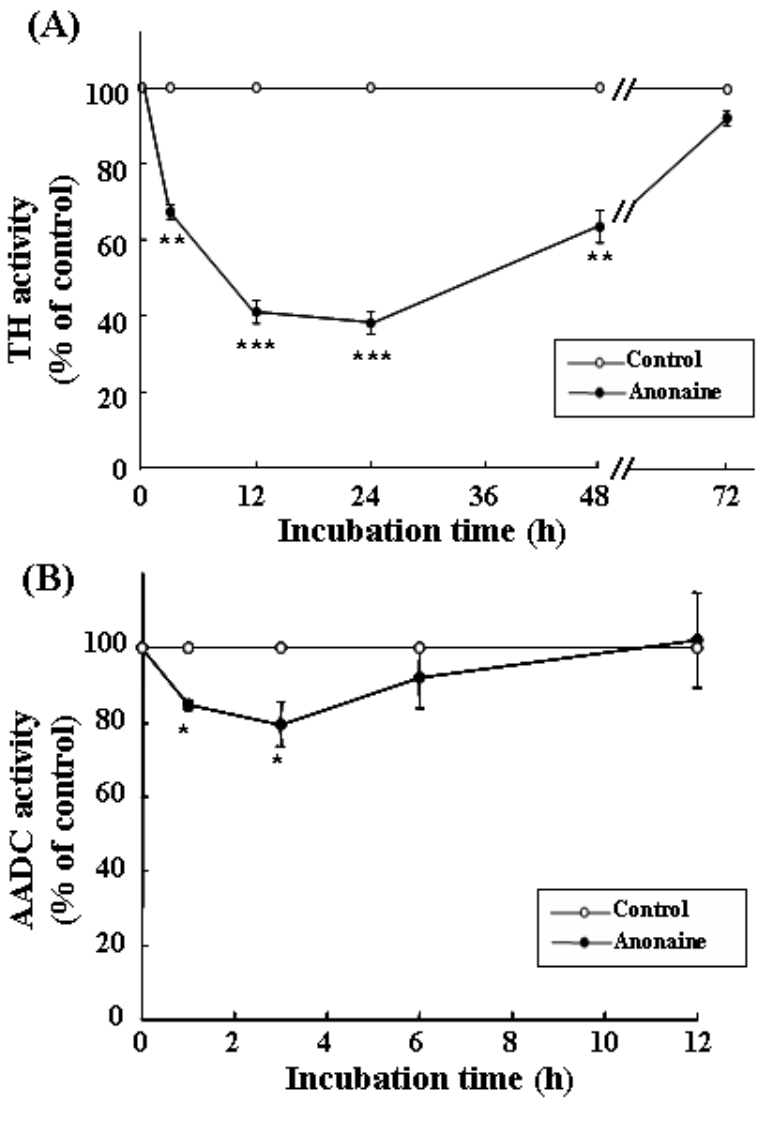
Figure 3. Time courses of TH (A) and AADC (B) activities by anonaine (0.05 µM) in PC12 cells. The control values of the activities of TH and AADC were 3.68 ± 0.29 and 32.5 ± 3.51 nmol/min/mg protein. Results represent means ± S.E.M. of 6-8 dishes. Significantly different from control values: *P<0.05, **P<0.01, ***P<0.001 (ANOVA followed by Tukey’s